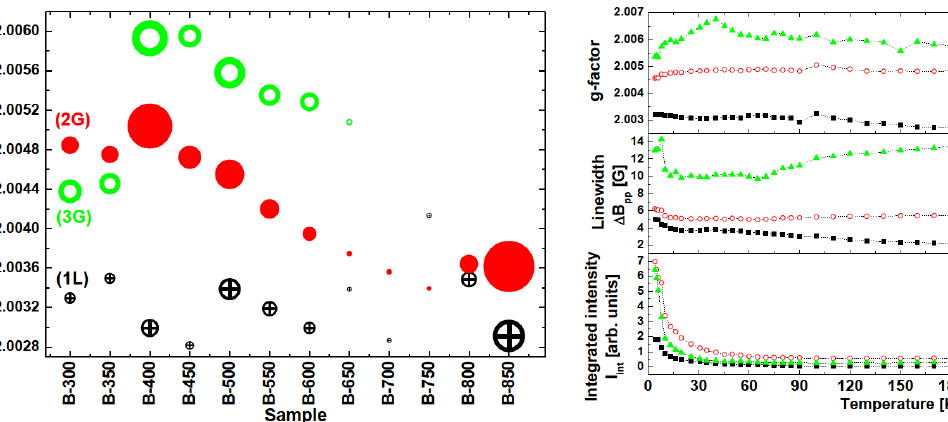
Figure 21: Temperature dependence of the g -factor (top panel), linewidth (middle panel), and integrated intensity (bottom panel) of the three subcomponents of the N component in B-400 sample.